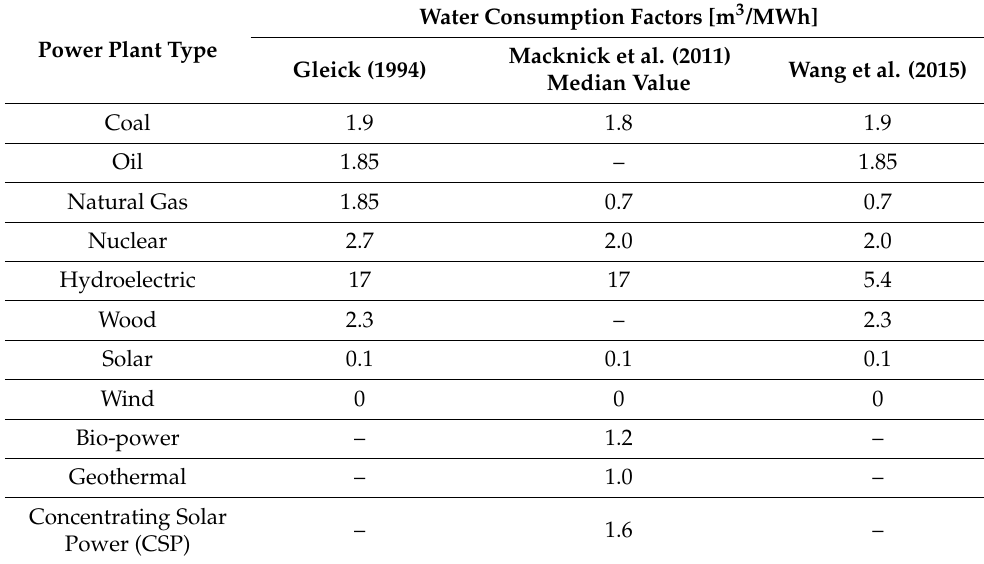
Table 7. Overall water consumption factors for electricity generation, after